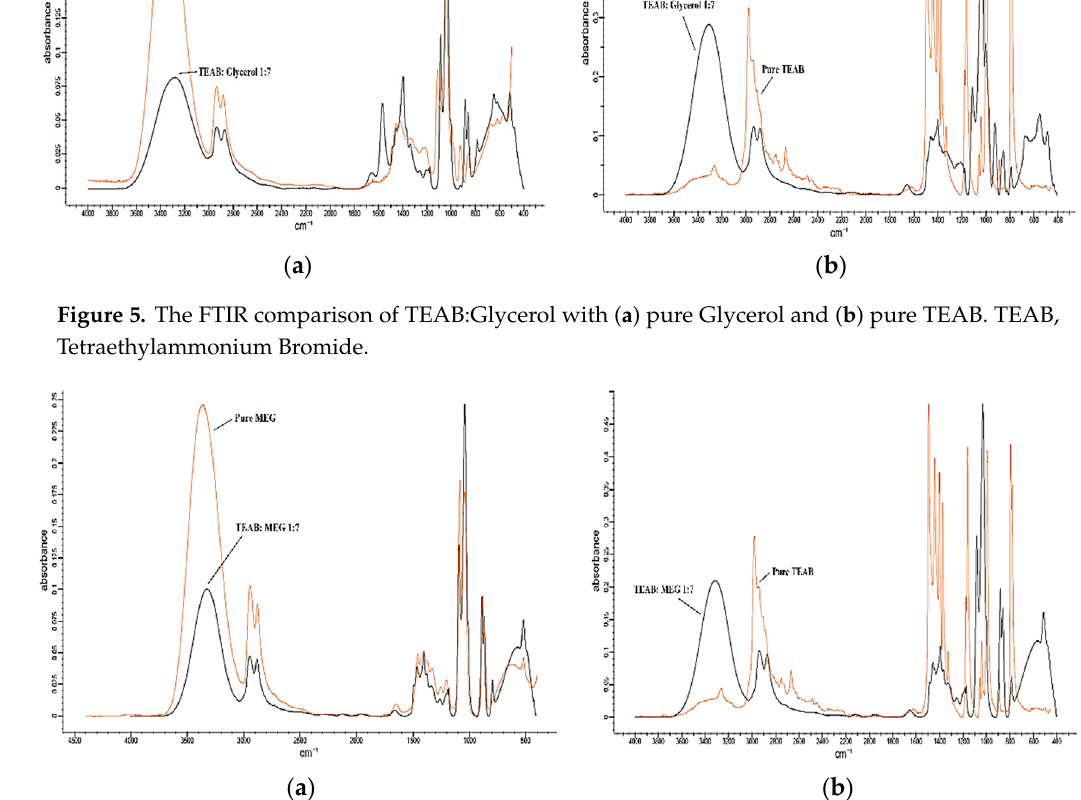
Figure 6. The FTIR comparison of TEAB:MEG with ( a ) pure MEG and ( b ) pure TEAB.